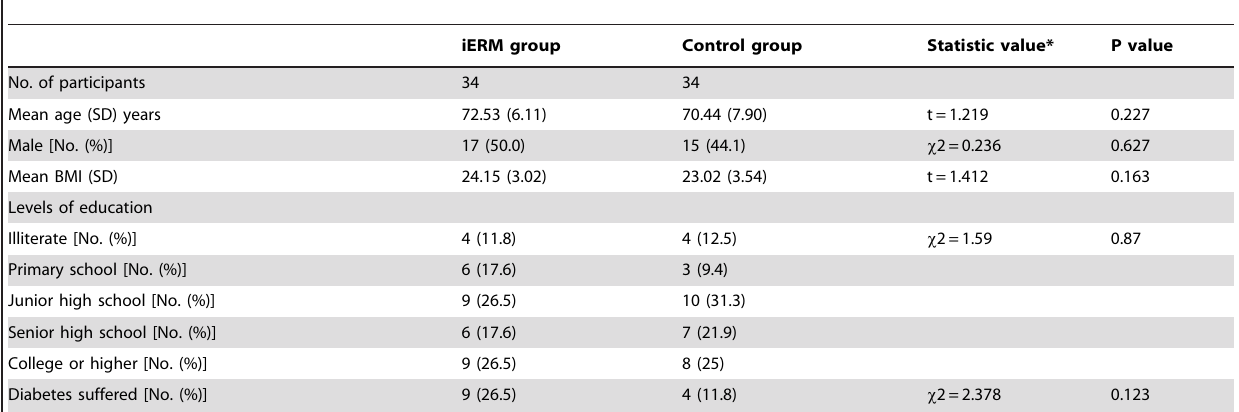
Table 3. Demographic characteristics in the 34 participants with iERM and the 34 healthy participants (control group).